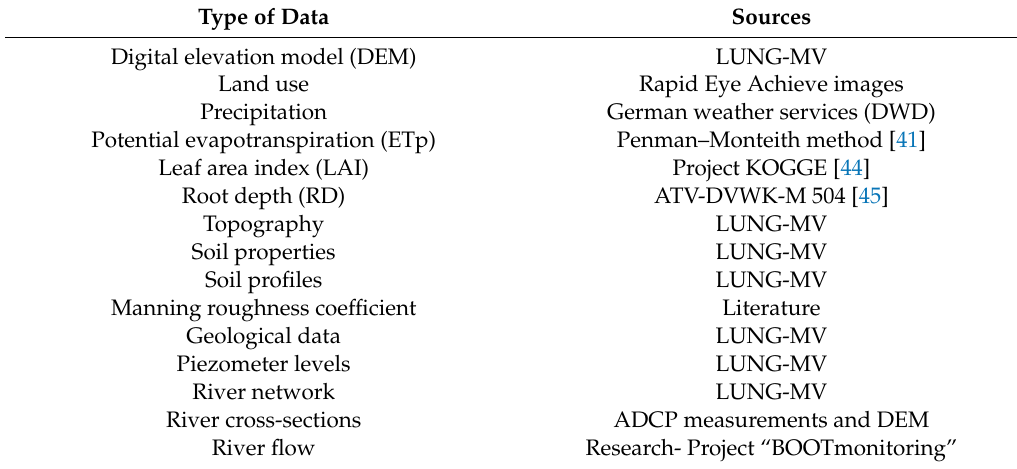
Table 1. Summary of the data used in this study and the sources from where the data is obtained.